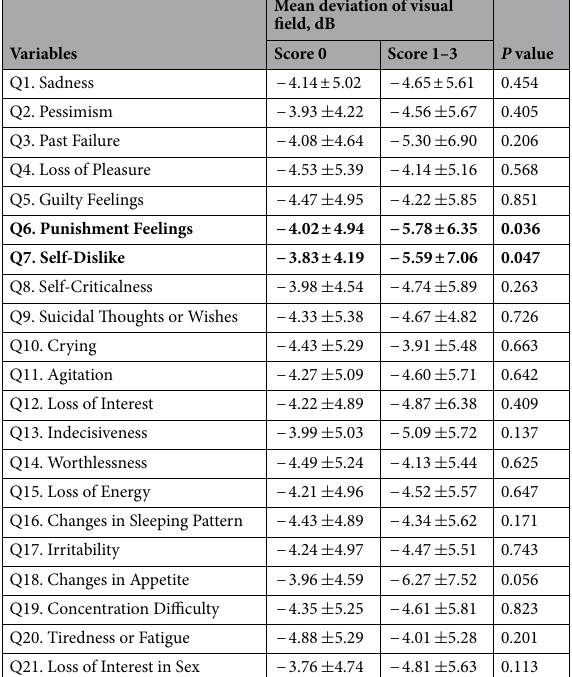
Table 7. The questions on the BECK Depression Inventory-II (BDI-II) associated with visual field mean deviation. The comparison was performed using independent samples t-test. Statistically significant values are shown in bold. Continuous data are mean ± mean standard deviation unless otherwise indicated.